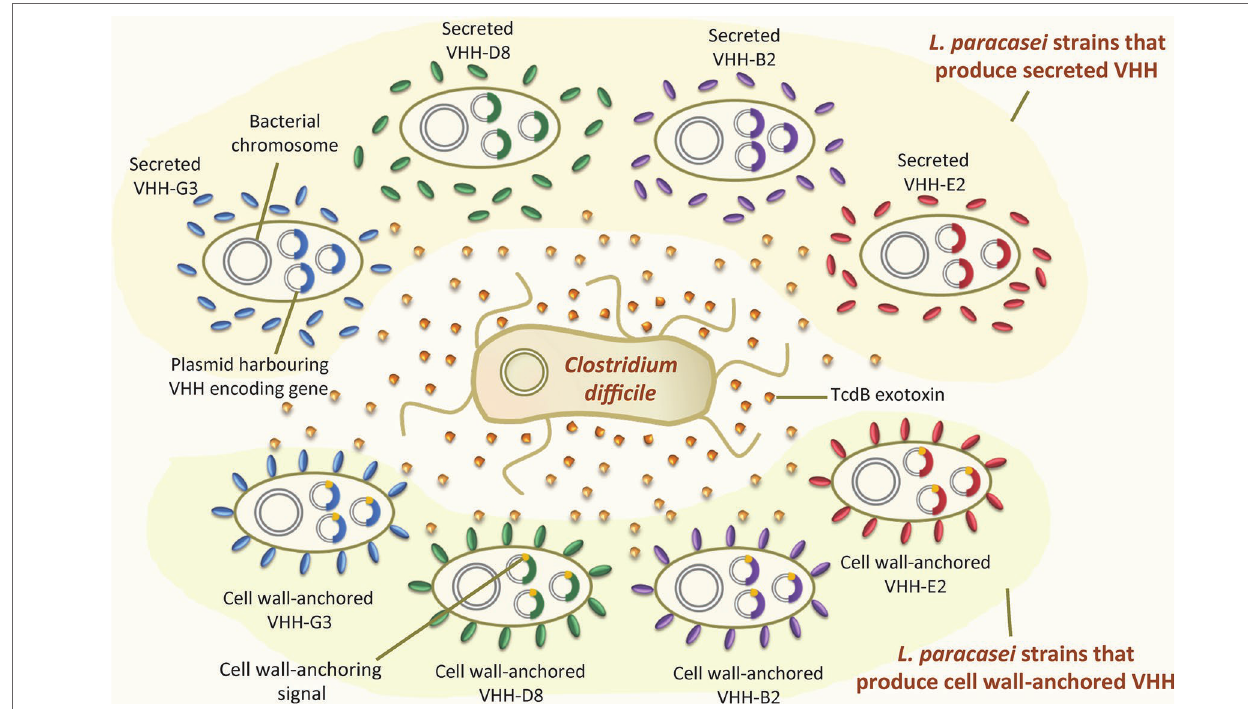
FIGURE 2 | Recombinant LAB that produce VHH against the TcdB exotoxin of Clostridium difficile. Recombinant Lactobacillus paracasei strains producing four different VHH (G3, D8, B2, and E2) against the TcdB exotoxin of Clostridium difficile . Some of these strains secrete the VHH into the extracellular environment, while others produce it covalently attached to the cell wall. The VHH-encoding genes are constitutively expressed within replicative plasmids inside the L. paracasei